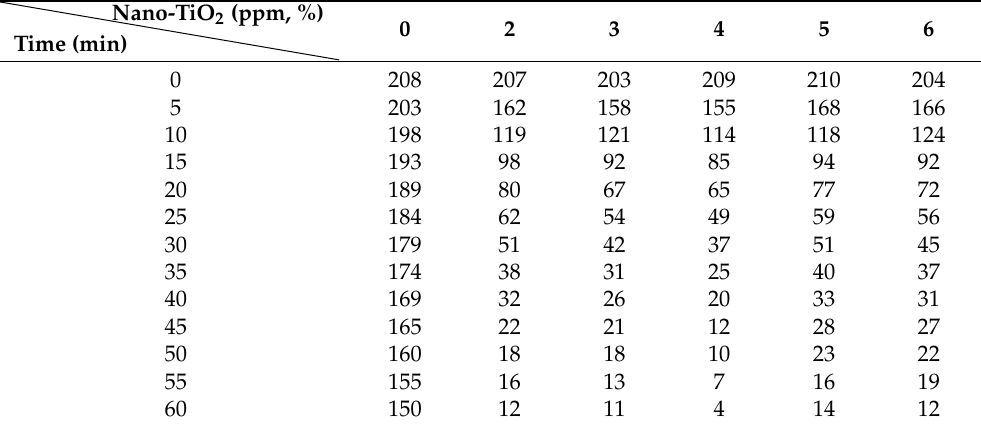
Table 2. NO concentrations tested in containers.